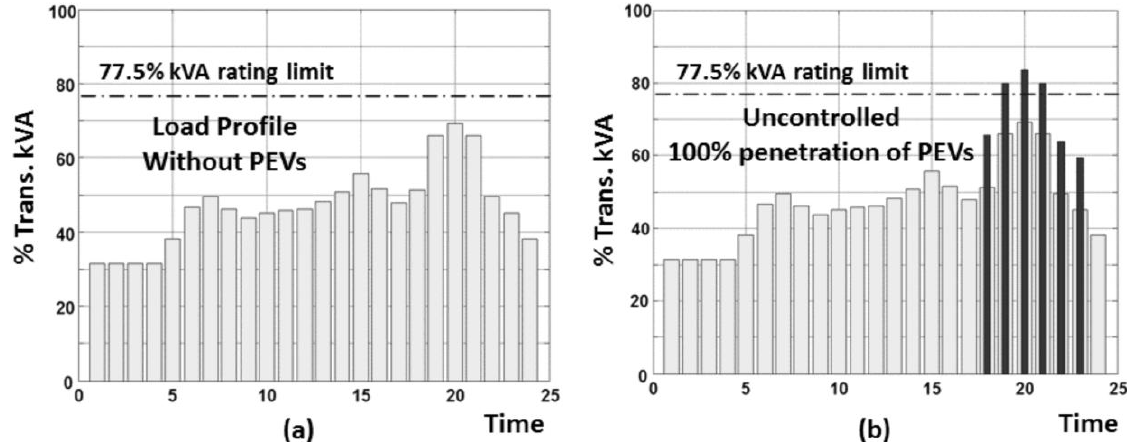
Figure 2. Distribution transformer load profile, ( a ) without PEVs and ( b ) with 100% penetration of 52